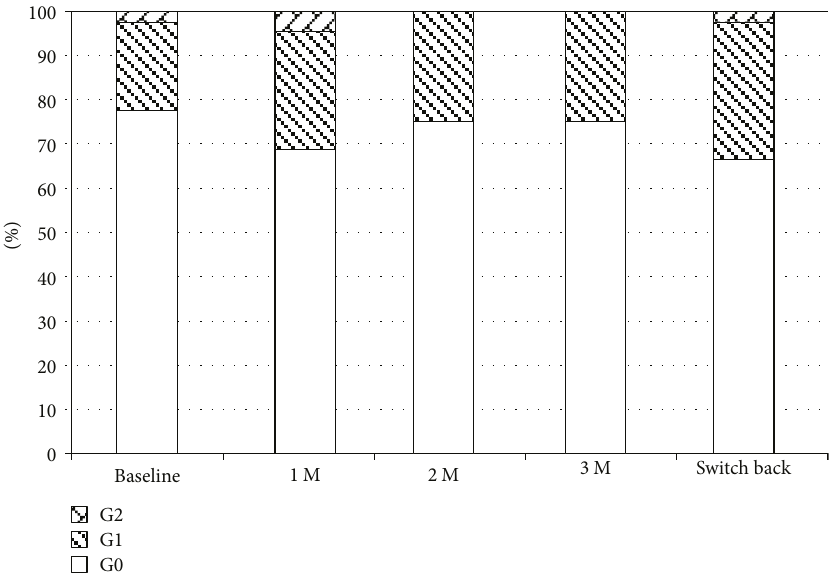
Figure 5: Changes in conjunctival hyperemia. M: months; G: